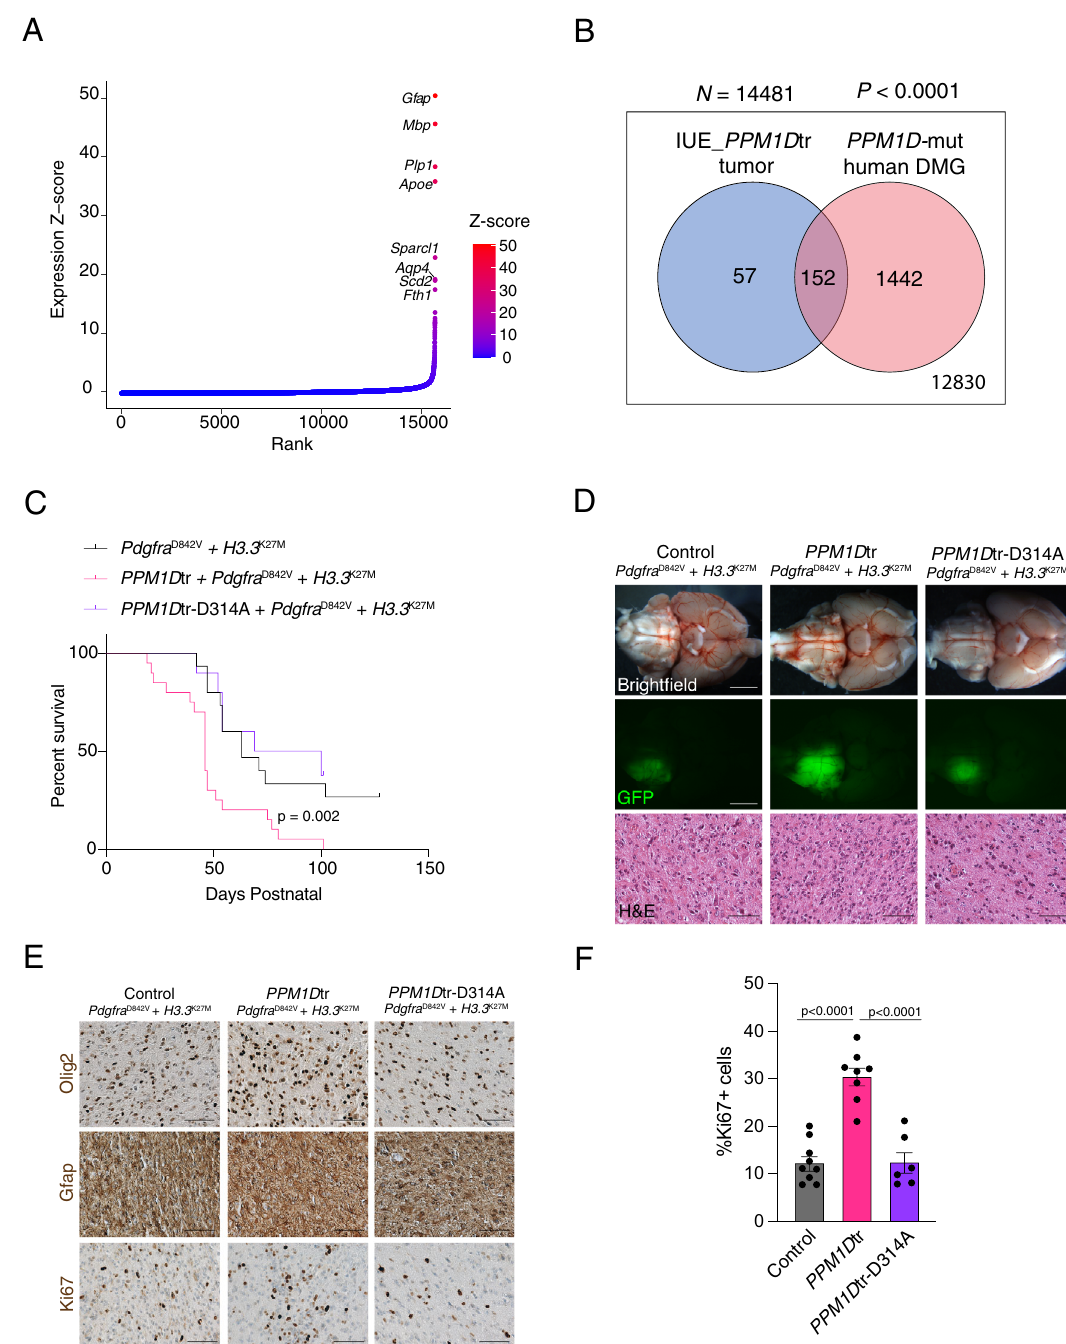
Fig. 2 Expression of human PPM1D tr potentiates DMG formation in vivo and requires the PPM1D phosphatase domain. A Plot showing ranked list of genes based on their expression Z-score in Ppm1d gRNA IUE DMG ( n = 3 tumors). Top genes with expression Z-score > 15 are depicted. B Venn diagram showing highly expressed genes (Z-score > 2) in Ppm1d gRNA IUE DMG ( n = 3), PPM1D -mutant human DMGs ( n = 7), and the overlap between two datasets. Total number of genes analyzed in both datasets is shown outside the box. P < 6.27e − 100 calculated using hypergeometric